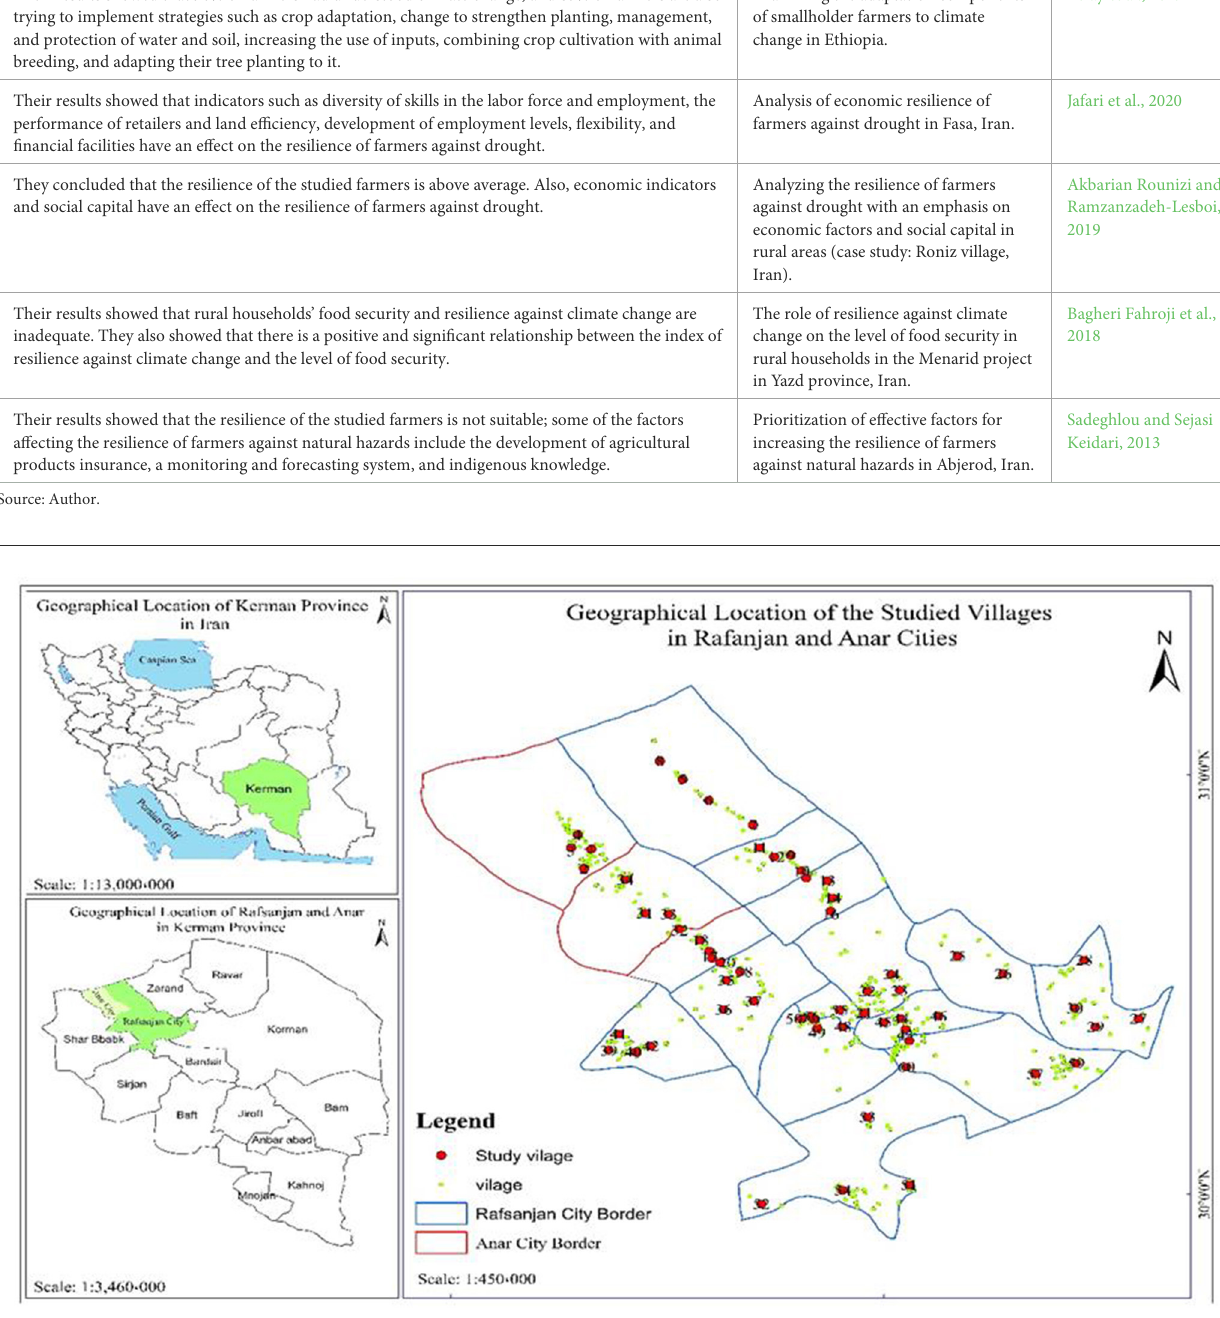
in the study area, with an error level of 4%. Lastly, several beneficiaries were randomly selected in each village, a form of proportional